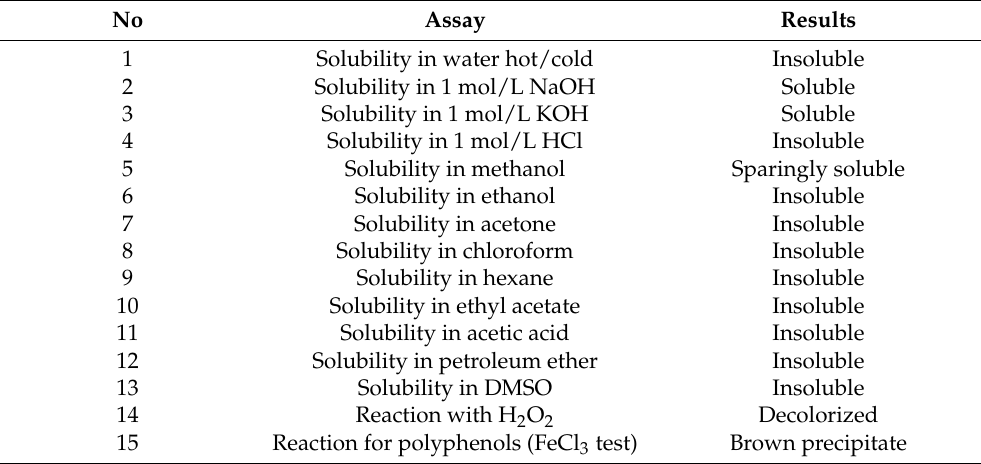
Table 1. Physical and chemical properties of the extracted melanin produced by G. oxydans FBFS 97.